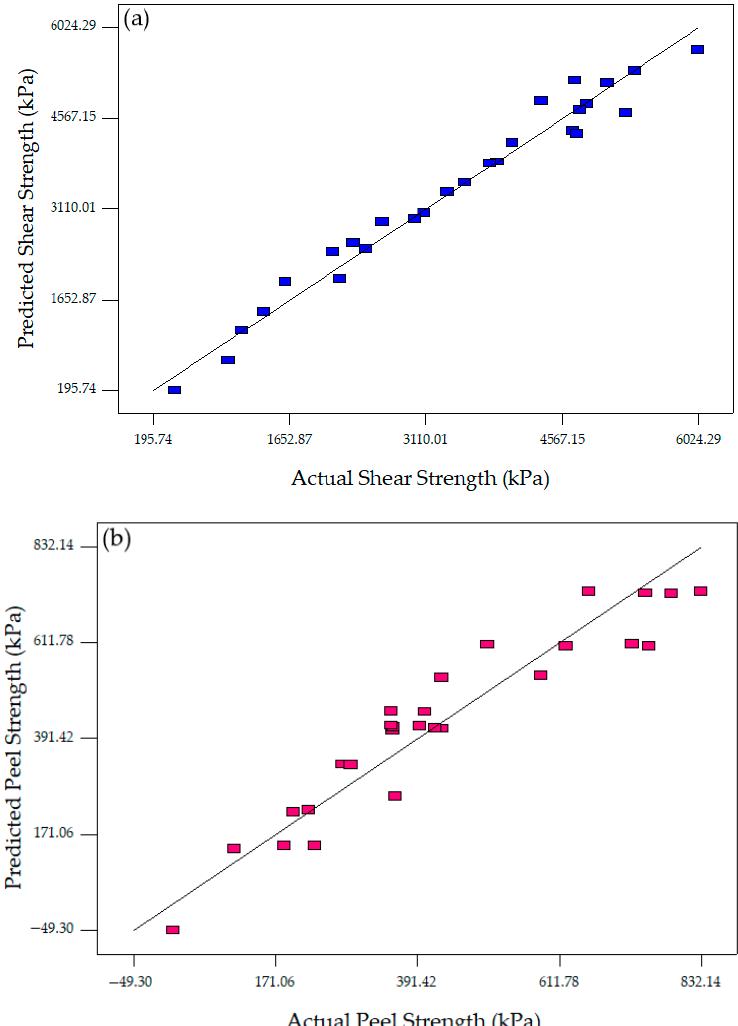
Figure 6. The plot of actual vs. predicted response: ( a ) shear strength and ( b ) peel strength.